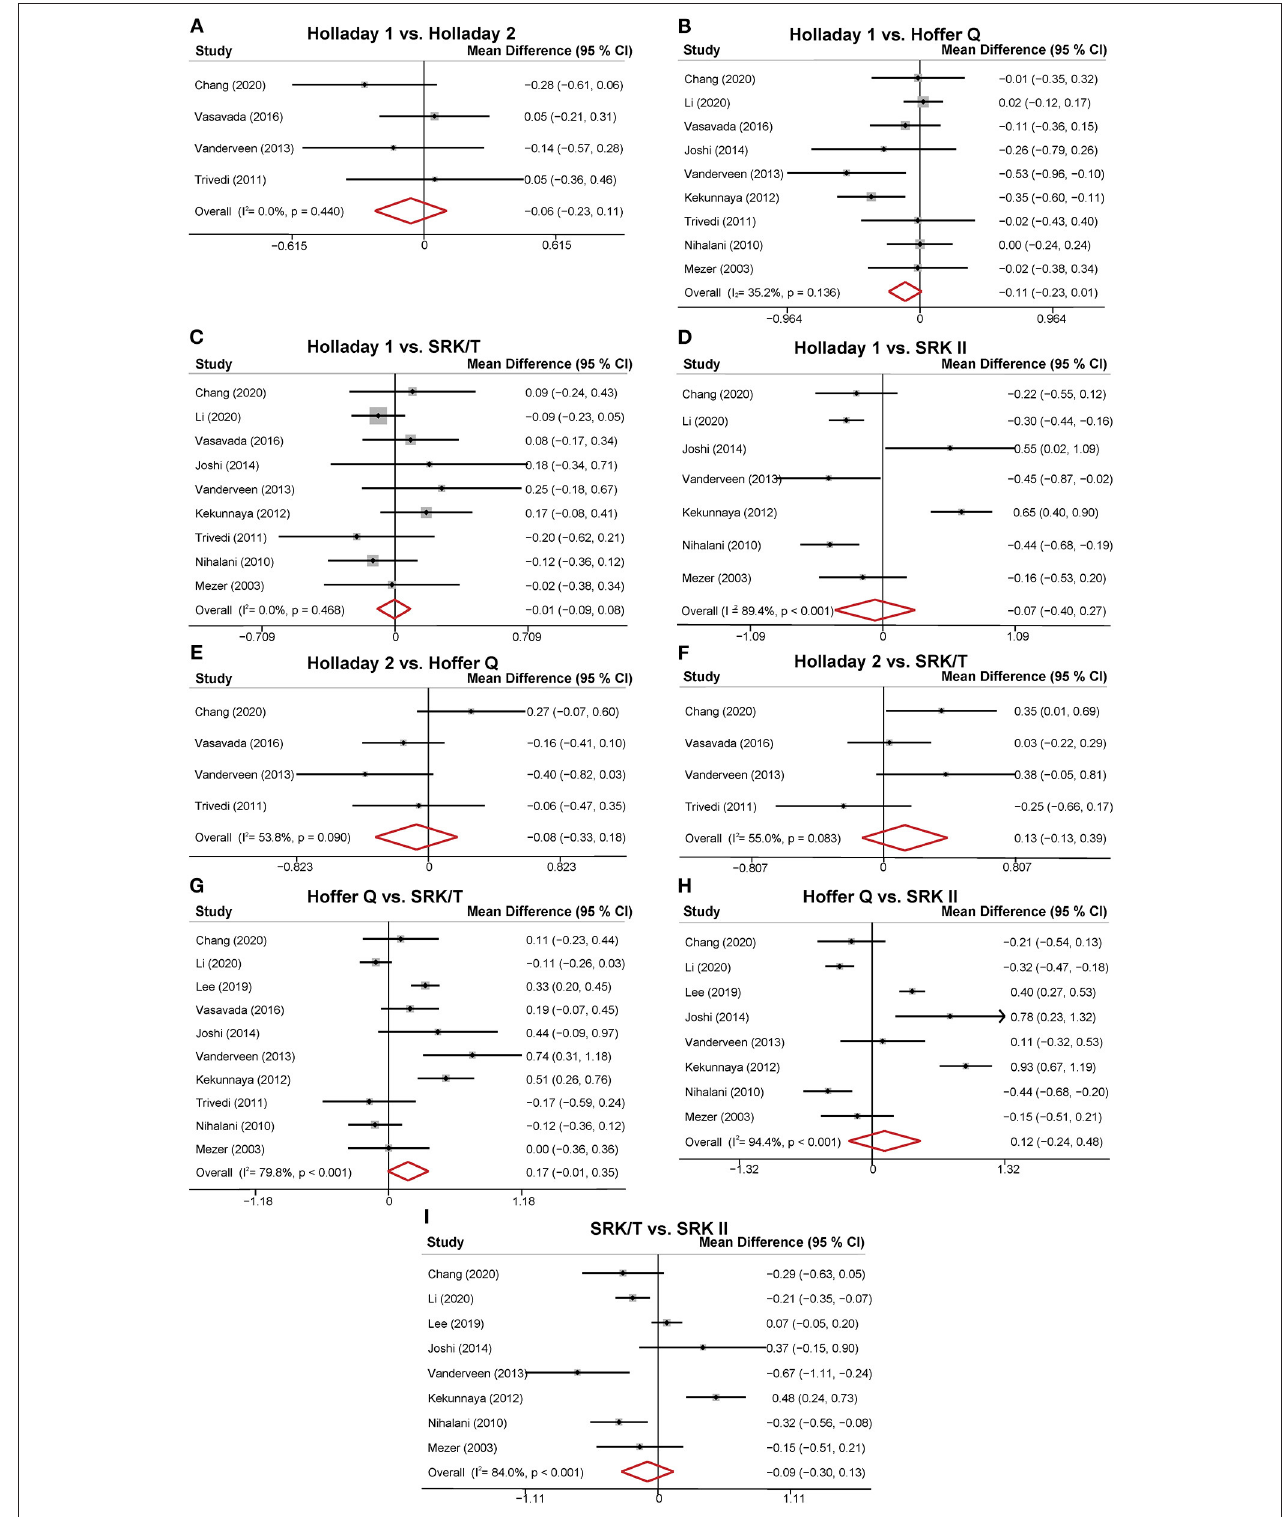
FIGURE 3 | Forest plot of the mean difference (MD) of absolute prediction error (APE) of the different formulas. (A) Holladay 1 vs. Holladay 2; (B) Holladay 1 vs. Hoffer Q; (C) Holladay 1 vs. SRK/T; (D) Holladay 1 vs. SRK II; (E) Holladay 2 vs. Hoffer Q; (F) Holladay 2 vs. SRK/T; (G) Hoffer Q vs. SRK/T; (H) Hoffer Q vs. SRK II; (I) SRK/T vs. SRK